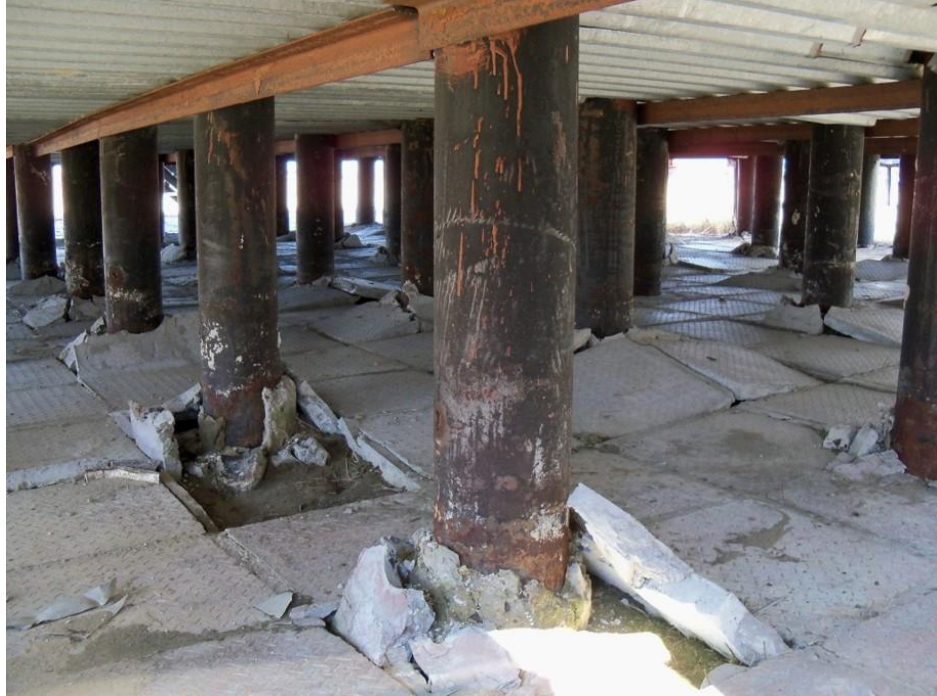
Figure 2. Piles affected by frost-heave uplift (gas field Zpolyarnoye, Western Siberia, Russia).